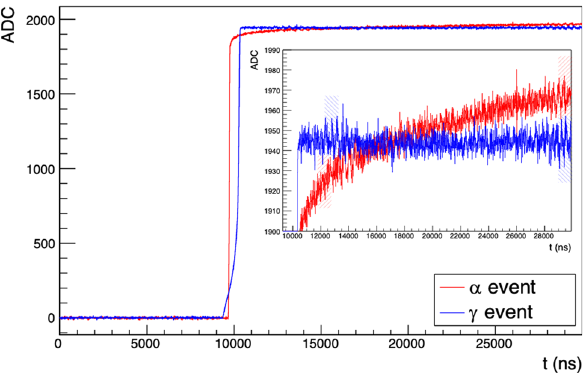
Fig. 1 Baseline-removed and pole-zero corrected waveforms from PONaMa-1 events, taken with the TUBE scanning system. Both the bulk γ event (in blue) and the surface α event, taken with the source incident at r = − 7 . 5mm (in red) , have 2615keV of energy. The wave- form regions used to calculate the DCR parameter for each waveform, determined as described in Sect. 2.4, are indicated by the shaded boxes, shown in the same color as the waveform they correspond